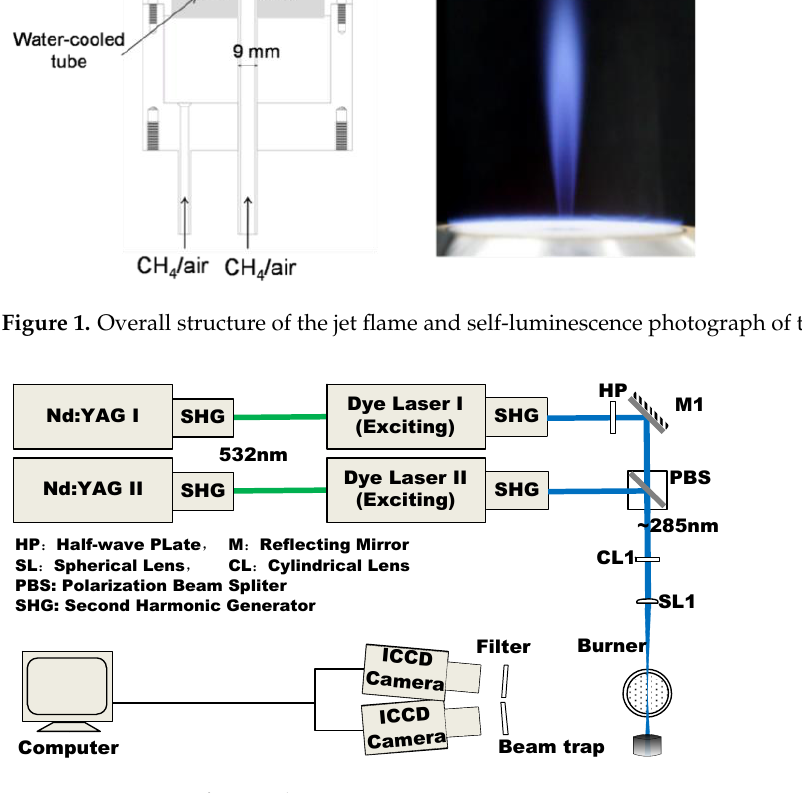
Figure 3. Two-dimensional Scanning CARS experimental facility.